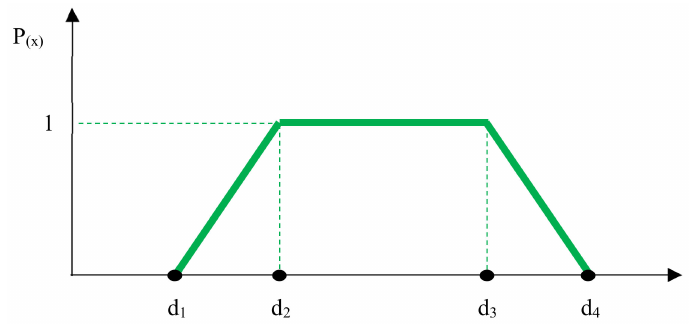
Figure 2. The trapezoidal possibility distribution of fuzzy